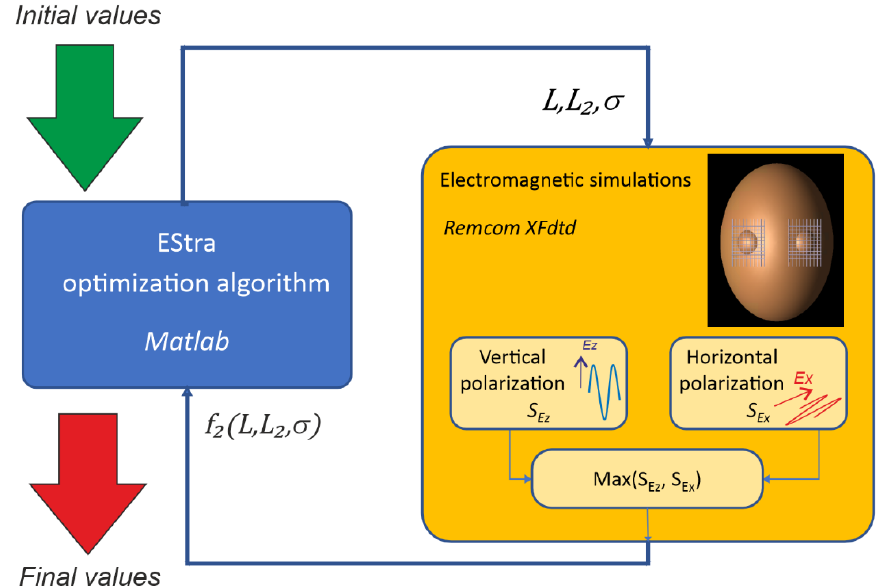
Figure 8. The procedure of the optimal design of the shielding structure.